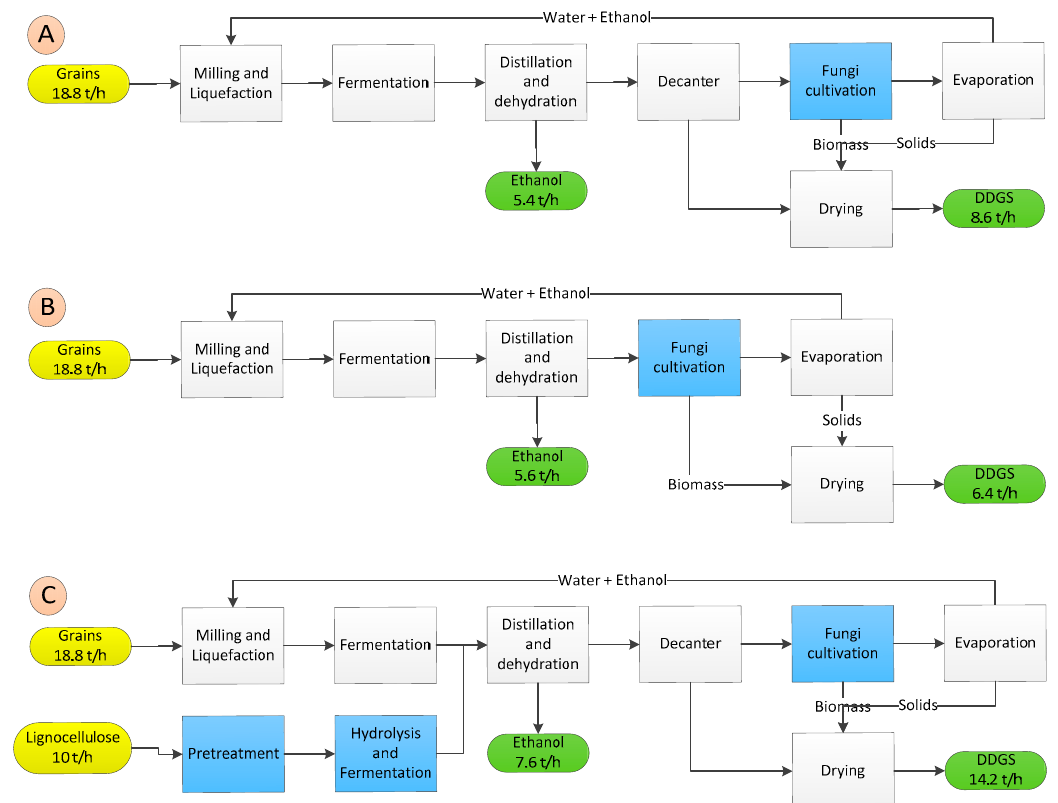
Figure 1. Block flow diagram of different scenarios studied, including modifications using filamentous fungi in the thin stillage ( A ) and the whole ‐ stillage ( B ) for the grains ethanol production. The integrated processes using lignocelluloses to thin stillage modified grains ethanol production is marked as ( C ).